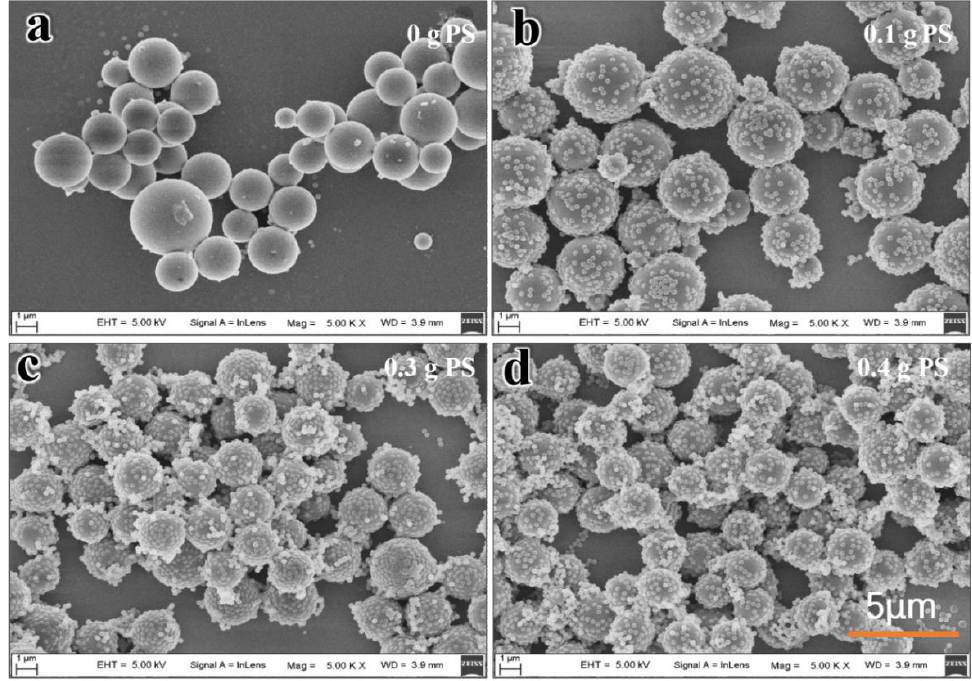
Figure 6. Effects of polystyrene (PS) latex contents on the SEM images of HSOS particles; ( a ) 0 g, ( b ) 0.1 g, ( c ) 0.3 g, ( d ) 0.4 g.